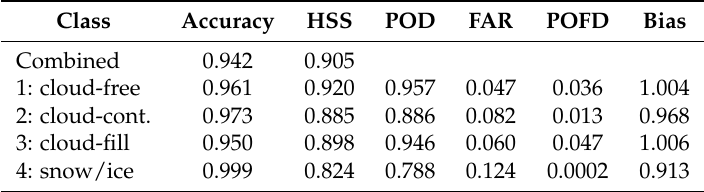
Table 4. Statistics for the scene from 22 February 2011 09:00:00